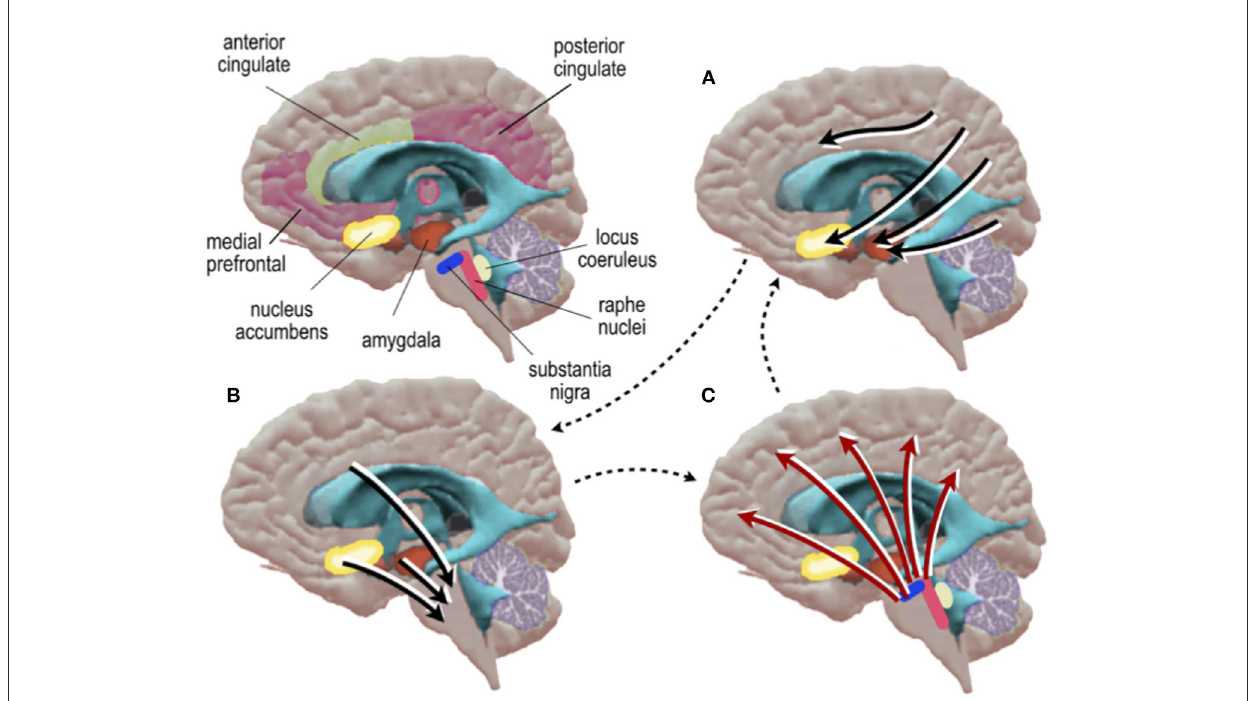
FIGURE3 Schematic diagram of a hypothetical indirect neurometabolic circuit. (A) Cortical activity is assigned valence by basal forebrain nuclei which in turn, (B) modify the activity of neurons in midbrain-brainstem nuclei which in turn, (C) modify regional energy distribution in